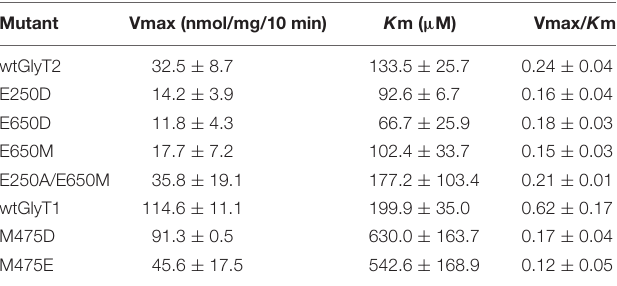
TABLE 1 | Kinetic parameters of glycine transport by GlyT2 and GlyT1 mutants in transfected COS7 (150 mM NaCl). Mutant Vmax (nmol/mg/10 min) K m ( µ